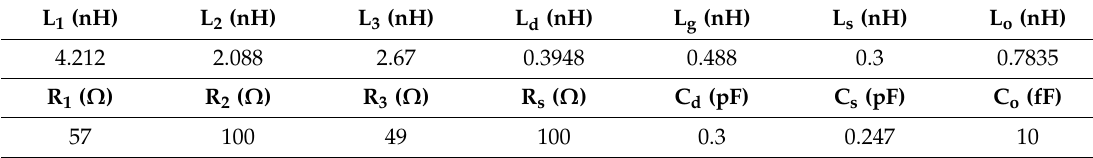
Table 2. Optimization result of di ff erent LNA